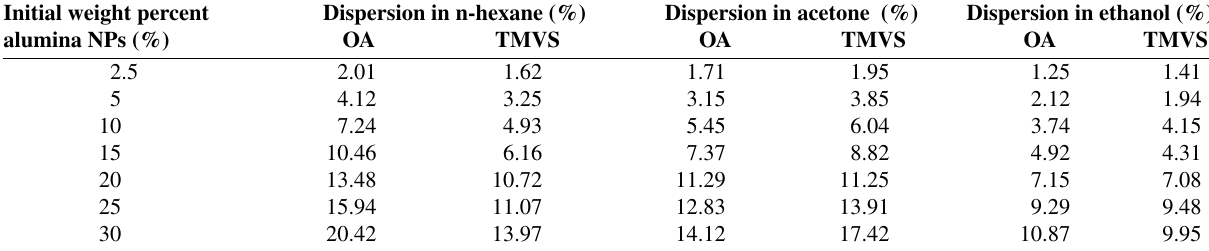
Table 4: Dispersion of alumina NPs modified with oleic acid (OA) and trimethoxy - vinylsilan (TMVS) in some organic solvents (%). Initial weight percent